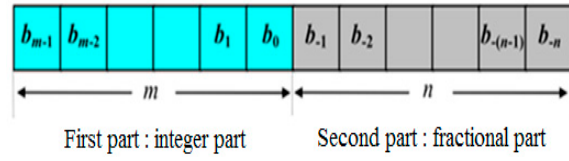
Figure 8. Representation of the fixed point digit.